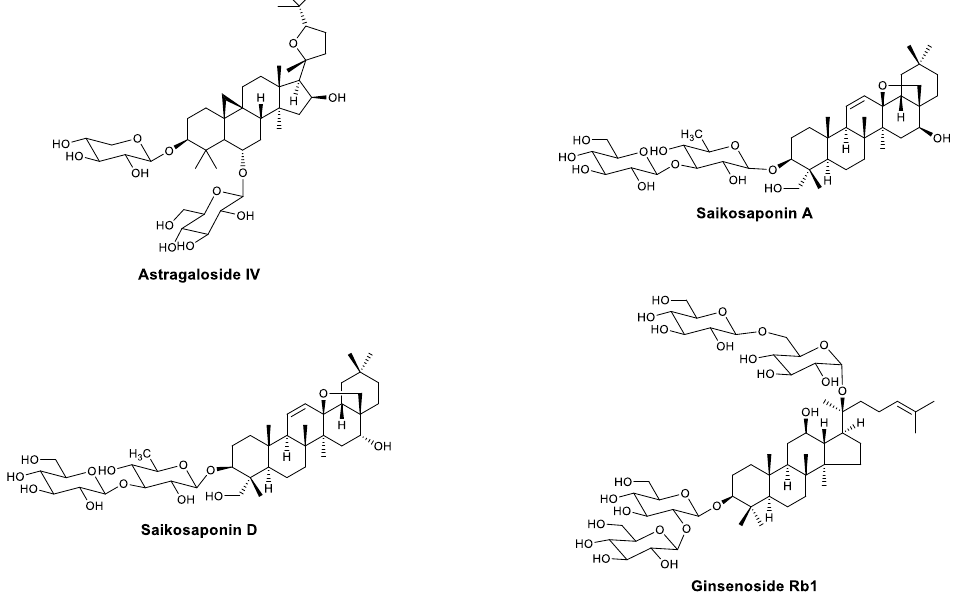
Figure 3. Structures of astragaloside IV, saikosaponins A and D, and ginsenoside Rb1. Celastrol (Figure 4) is a terpenoid isolated from Tripteryguim regelii (Celastraceae) that has been identified as having antiviral activity toward SARS-CoV [41], HIV [42], and DENV [43]. The antiviral mechanisms include both directly interacting with viral proteins and modulating immunity. In Yu’s research, celastrol inhibited the replication of DENV in Huh-7 cells and protected DENV-infected mice from death and paralysis. Further in- vestigation showed that celastrol activates the JAK/STAT signaling pathway, which leads to the expression of IFN- α , initiating an antiviral state in host cells [43].